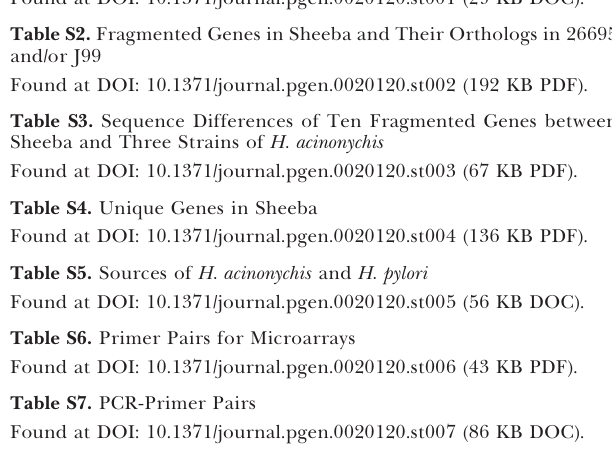
Table S1. Synonymous and Non-Synonymous Distances in Pair-Wise Comparisons of 612 Conserved Genes among Three Helicobacter